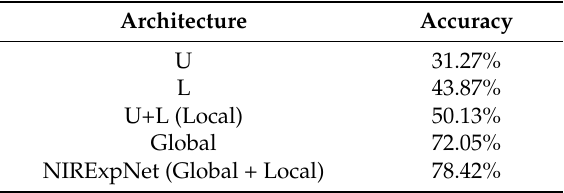
Table 3. Comparisons of different streams